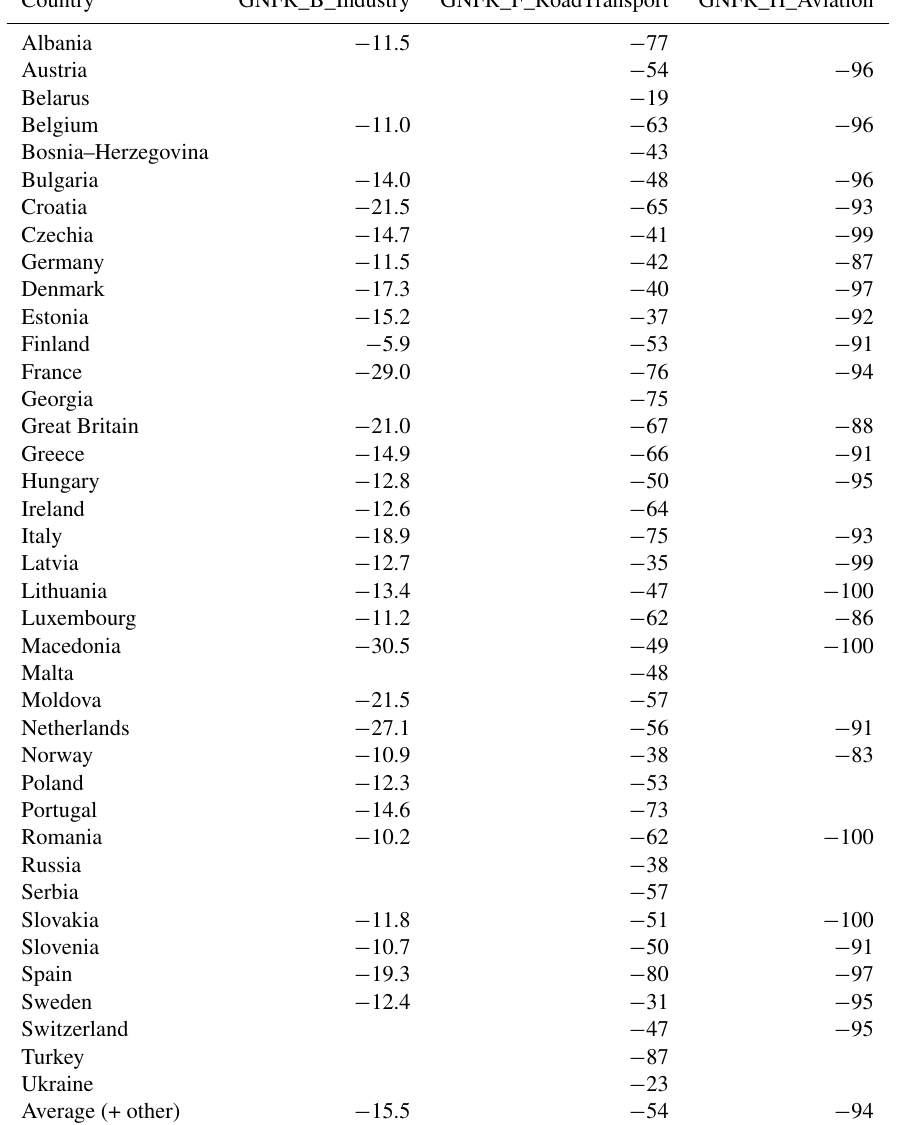
Table C1. Reduction factors (%) by country and activity sector corresponding to the lockdown period over the modelled European domain. Country GNFR_B_Industry